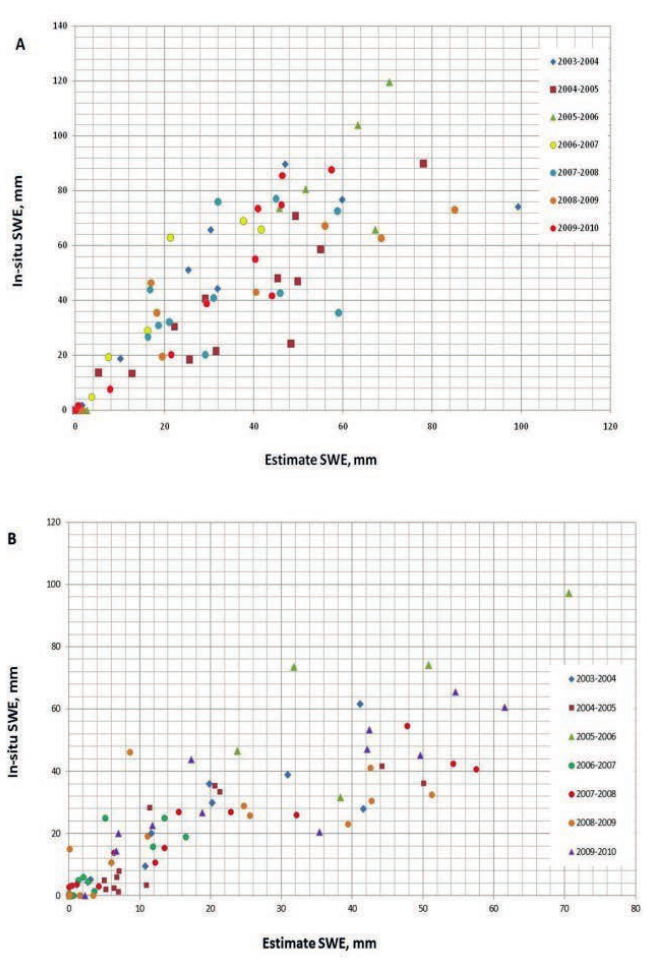
Fig. 4 Linear relationship between the in situ and estimated SWE in different periods for the basins of the Oka (А) and Don